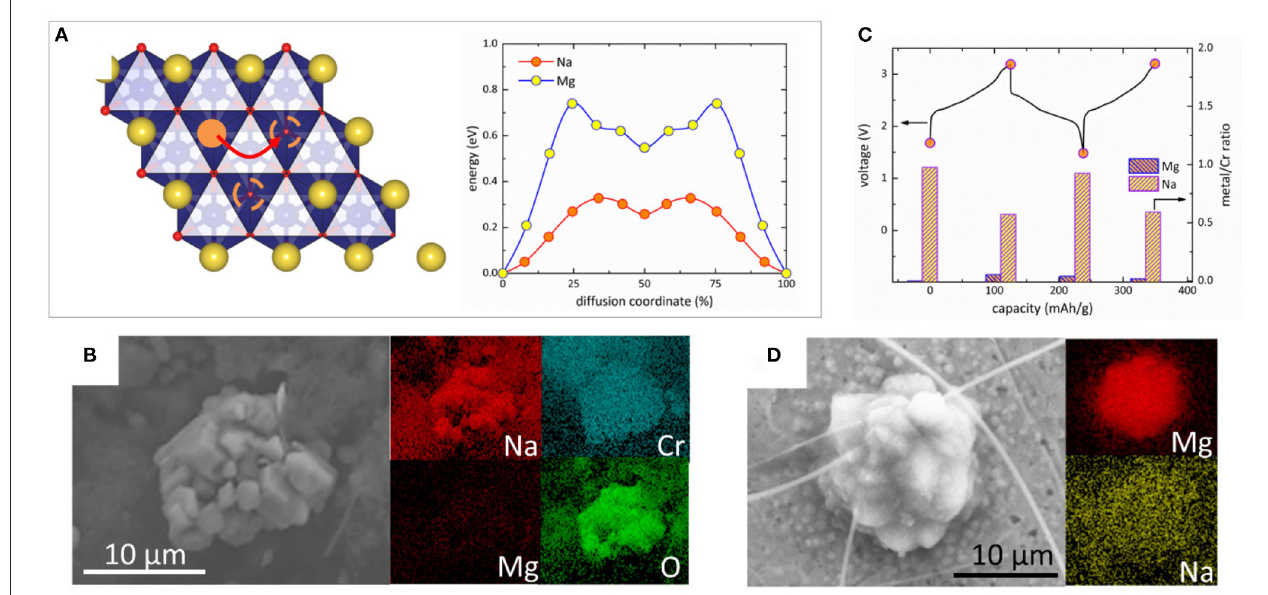
FIGURE 4 | Analysis of the electrochemical reactions at the NaCrO 2 cathode and metal Mg anode in Mg-NaCrO 2 cell. (A) Diffusion barrier of Mg 2 + and Na + in the divacancy mechanism. The mobile ion is shown as solid orange circle while the vacancies are shown as dashed circles. Na and CrO 6 octahedra are shown in yellow and blue color, respectively. (B) SEM and EDS analysis of discharged cathode. (C) Variation of Mg and Na content in the cathode measured by EDS in two charge-discharge cycles. (D) SEM and EDS analysis of a particle deposited on stainless steel anode in charge. The spikes are ceramic residuals from the separator.